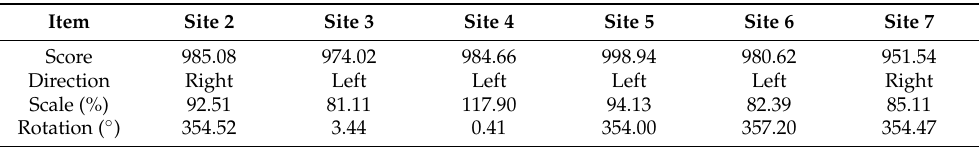
Table 2. Field experimental results of autonomous driving robot for recognizing the road signs in the underground